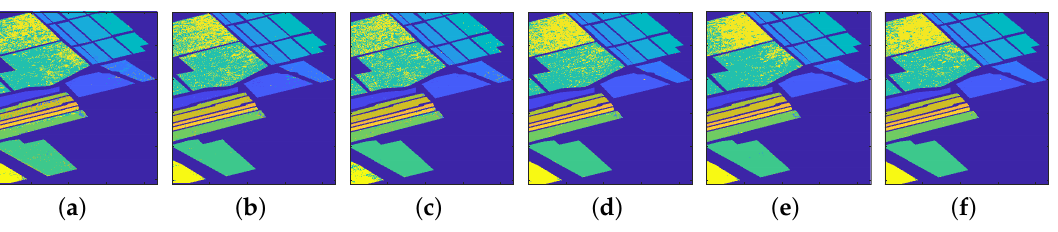
Figure 15. SVM classification maps of using the ten bands selected by different methods from the Salinas dataset. ( a ) MVPCA ( b ) LCMVBCC ( c ) LCMVBCM ( d ) ECA ( e ) OPBS ( f ) MRMR.